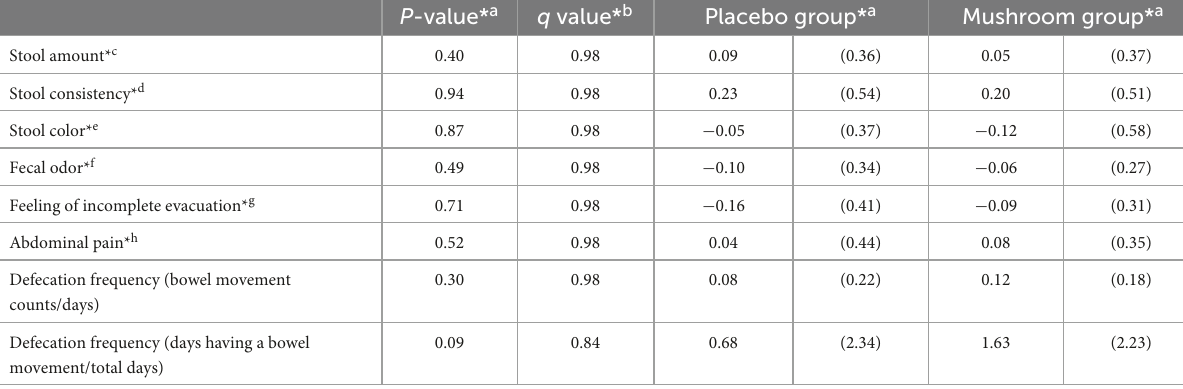
TABLE 3 Statistical test results for defecation data.